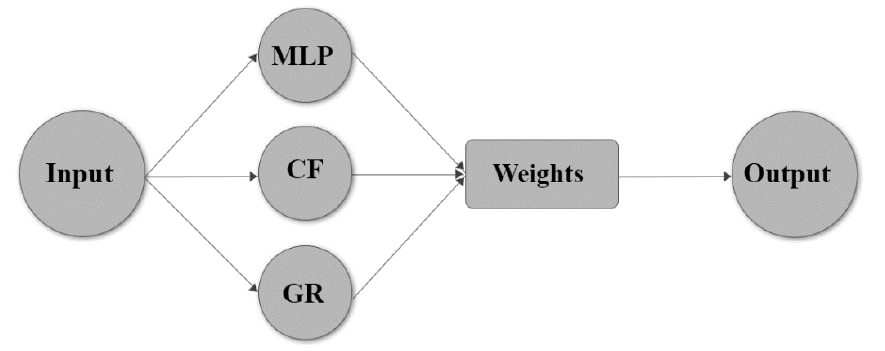
Figure 2. Structure of the committee neural network.